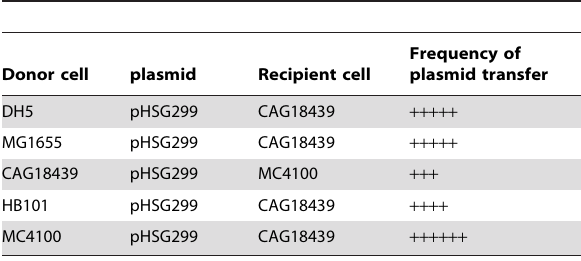
Table 3. Lateral plasmid transfer with various combinations of strains and plasmids in liquid